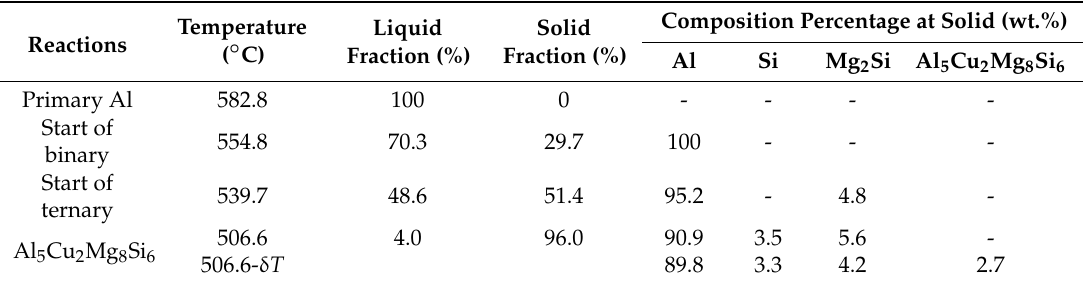
Figure 3. Changes of liquid and solid fractions with temperature decrease during solidification process of Al-8Zn-6Si-4Mg-2Cu alloy ( a ), detailed diagram at solid fraction ( b ). Table 2. The liquid and solid fractions for basic Al-8Zn-6Si-4Mg-2Cu alloy transition reaction.